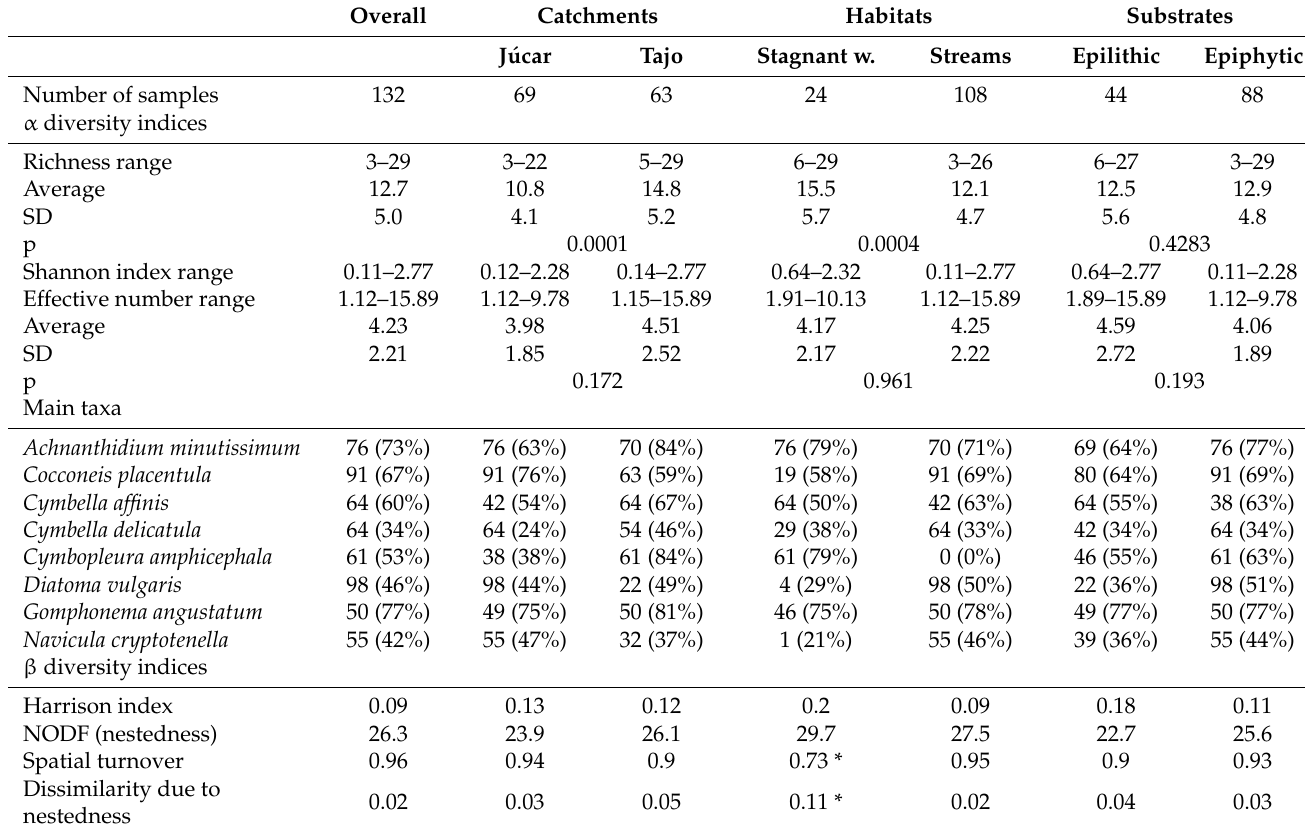
Table 3. Alpha diversity indices, maximal relative abundances and percentage of occurrence